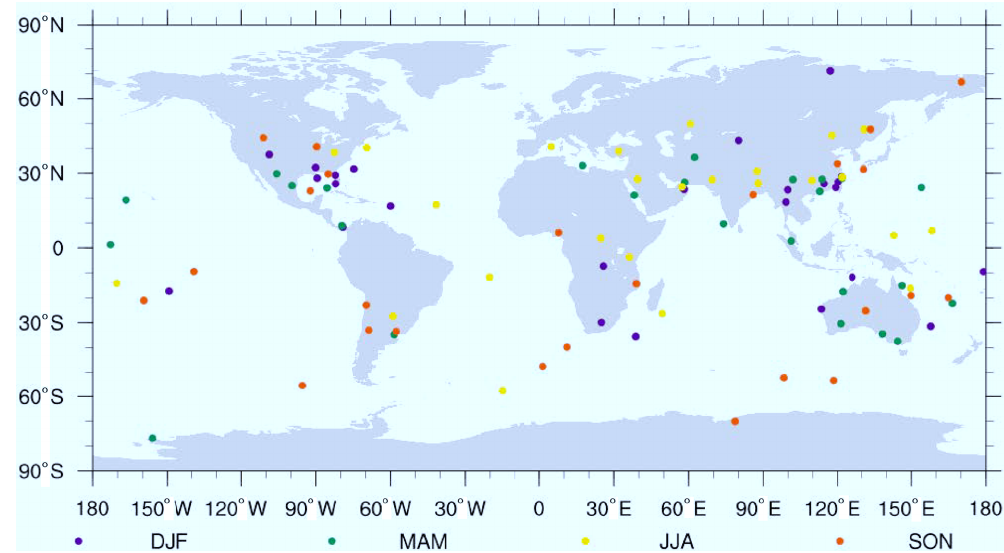
Figure 3. The location of the 100 selected clear-sky profiles from SeeBor used in the simulations.